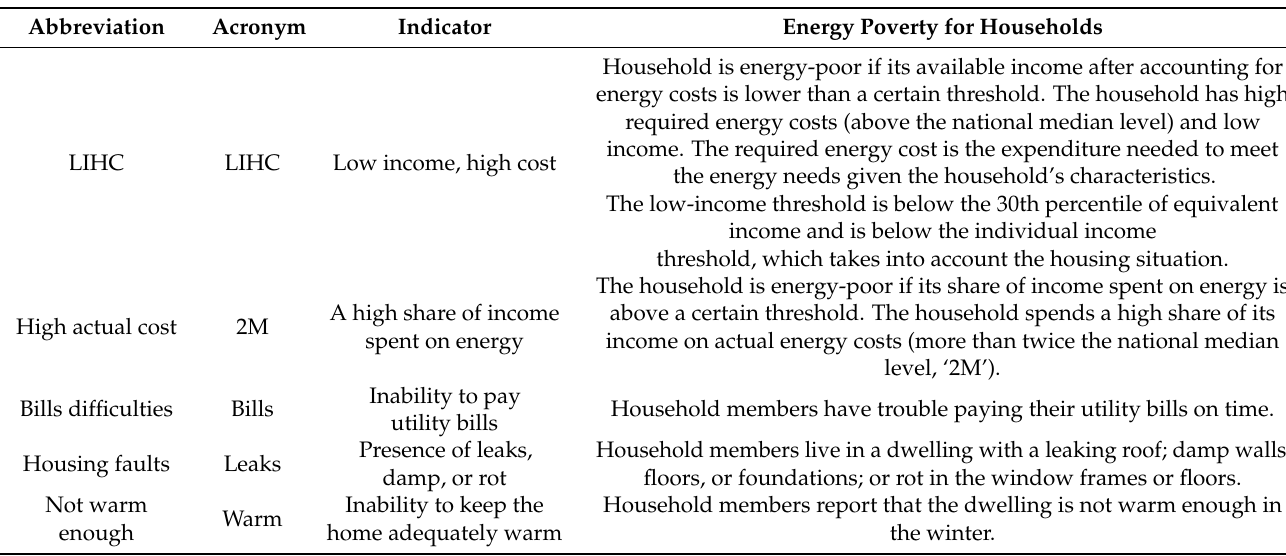
Table 1. Main indicators and areas of energy poverty descriptions.